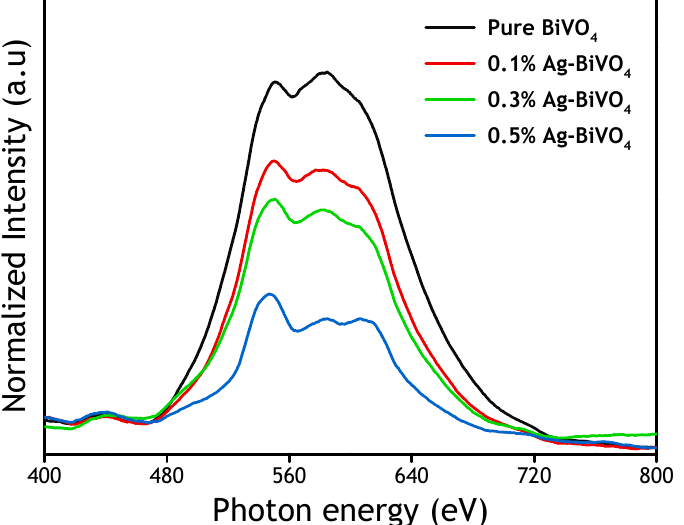
Figure 7. X-ray-excited optical luminescence (XEOL) of BiVO 4 with and without decoration with Ag NPs.